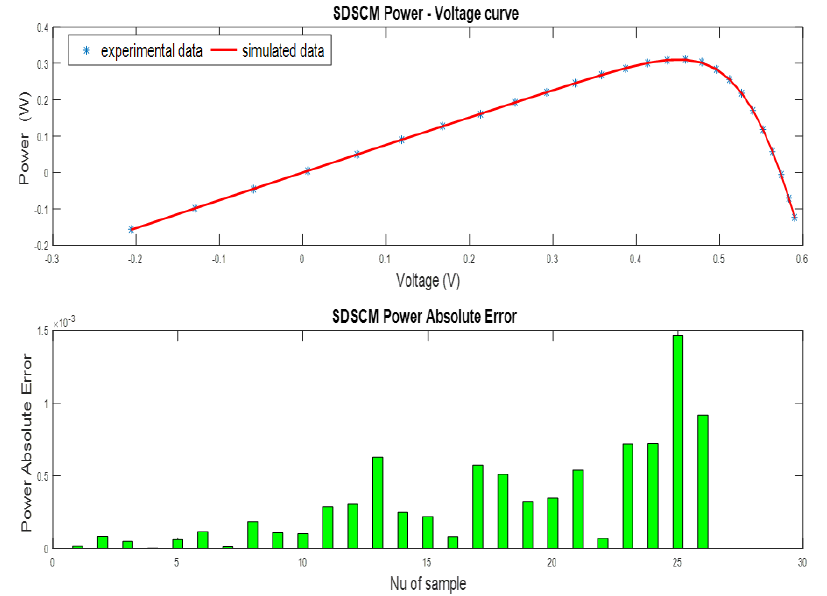
Figure 5. The P-V curve and power absolute error for